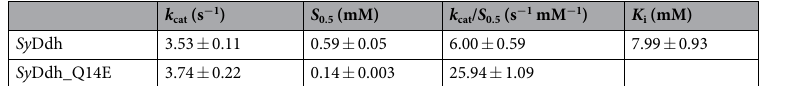
Table 2. Kinetic parameters of Sy Ddhs for pyruvate in the presence of 2.5 mM MgCl 2 . Parameters were calculated as described in the Materials and Methods. k cat , S 0.5 , and k cat / S 0.5 are the turnover rate, half-maximum concentration giving rise to 50% V max , and catalytic efficiency, respectively. The inhibition constant ( K i ) is shown when the data exhibited substrate inhibition. Data represent the mean ± SD from three independent